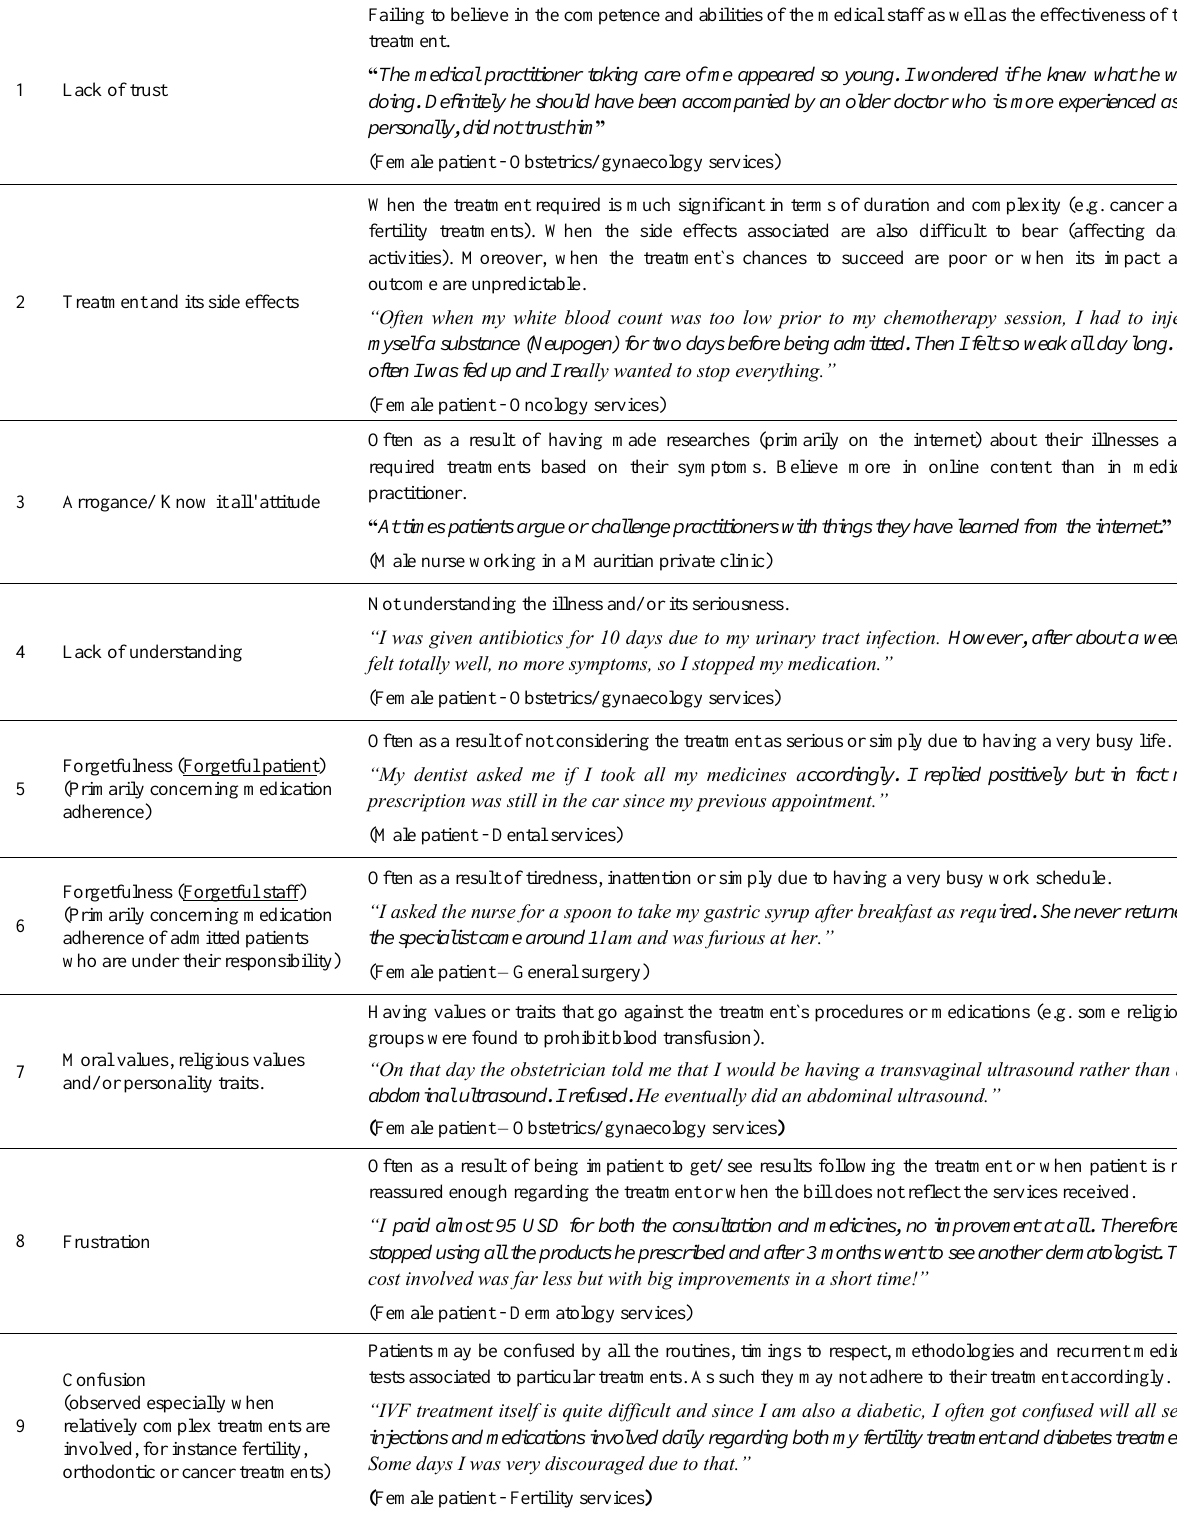
Table 3. Other factors observed to affect patient compliance throughout the patient care